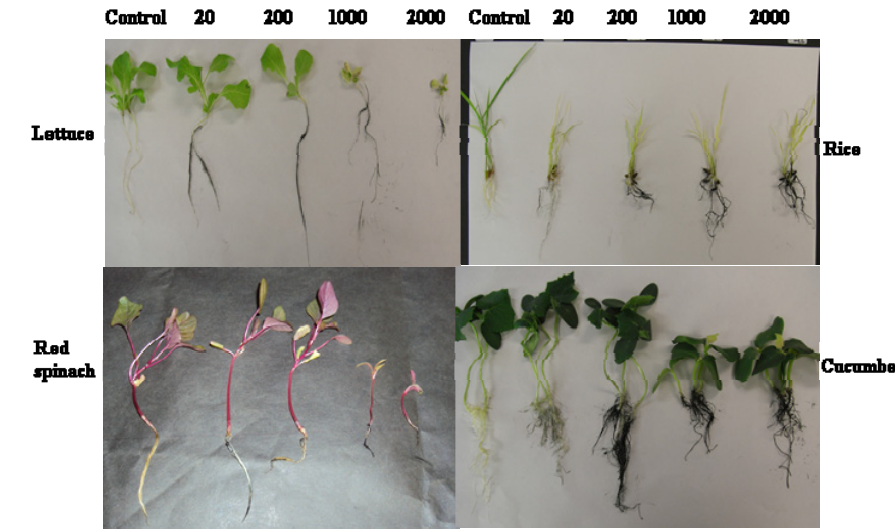
Figure 2. Morphological observations of red spinach, lettuce, rice, and cucumber exposed to MWNTs at 0, 20, 200, 1000, or 2000 mg/L for 15 days. Reproduced with permission from reference [16], Copyright 2012,